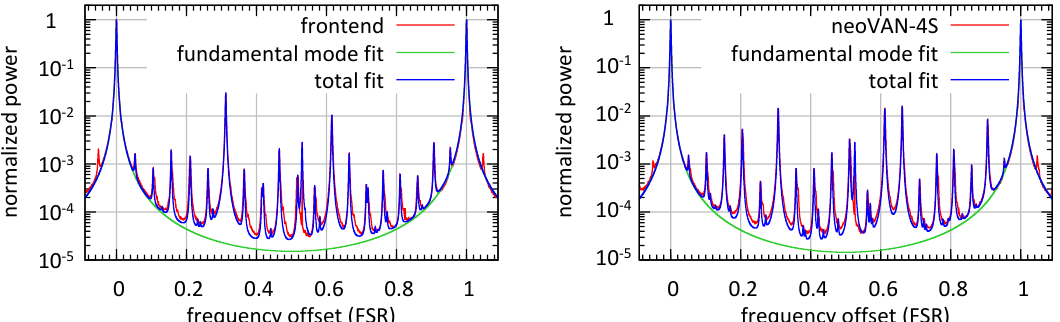
Figure 2. ( Left ) Modescan of the laser beam coming from the front-end. The higher order mode content of the laser beam was < 5.7%. ( Right ) Diagnostic breadboard (DBB) modescan of the laser beam amplified by the neoVAN-4S amplifier. The higher order mode content of the laser beam was <